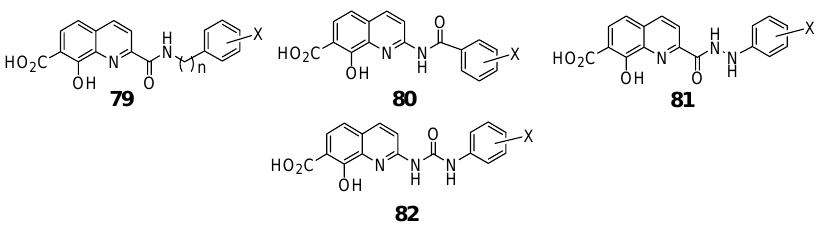
Figure 3. Structure of inhibitors exhibiting a nitrogen containing